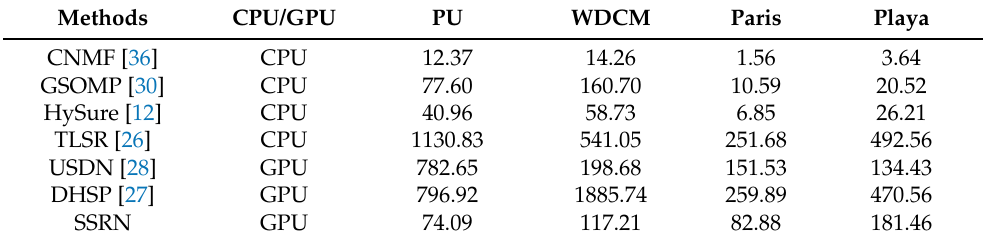
Table 9. Time cost of different methods on different databases (seconds).